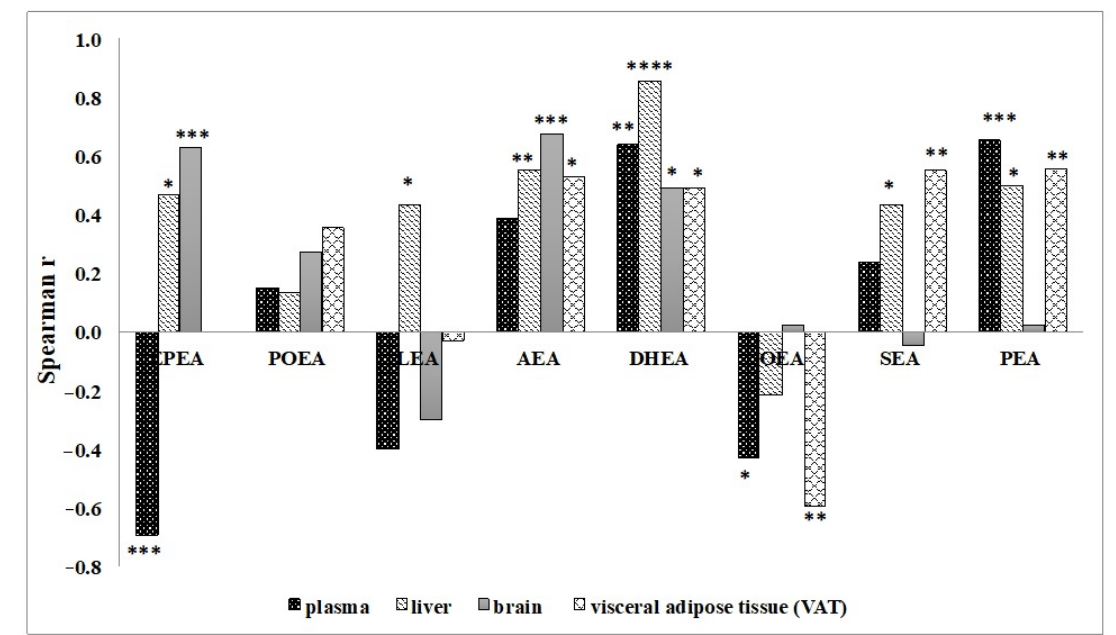
Figure 1. Correlations between NAE species and their respective FA precursors, in plasma, liver, adipose tissue and brain analyzed in Wistar rats fed with different diets. The correlations studies were determined by Spearman correlation coefficient. Statistical significance as follow: * p ≤ 0.05; ** p ≤ 0.01; *** p ≤ 0.001; **** p ≤ 0.0001. EPEA, N-eicosapentaenoylethanolamide; POEA, N-pamitoleoylethanolamide; LEA, N-linoleoylethanolamide; AEA, N-